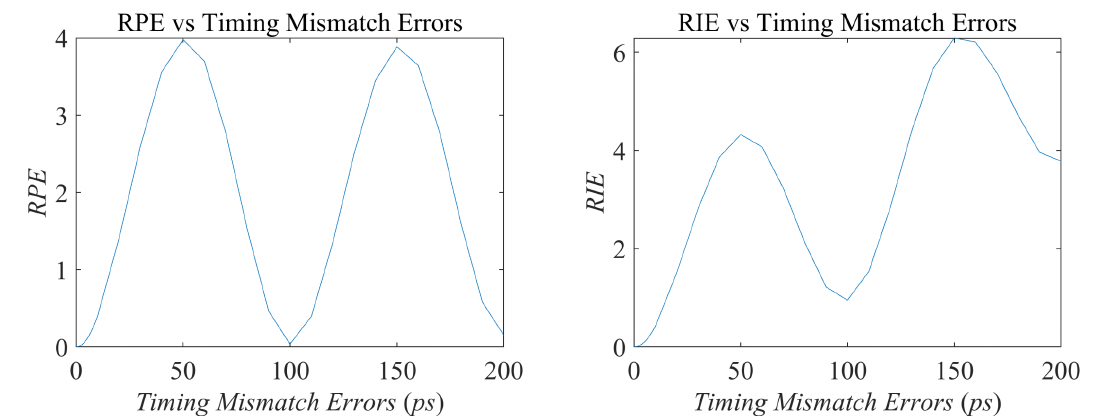
Figure 7. Relative perturbation error (RPE) and relative imaging error (RIE) versus timing mismatch